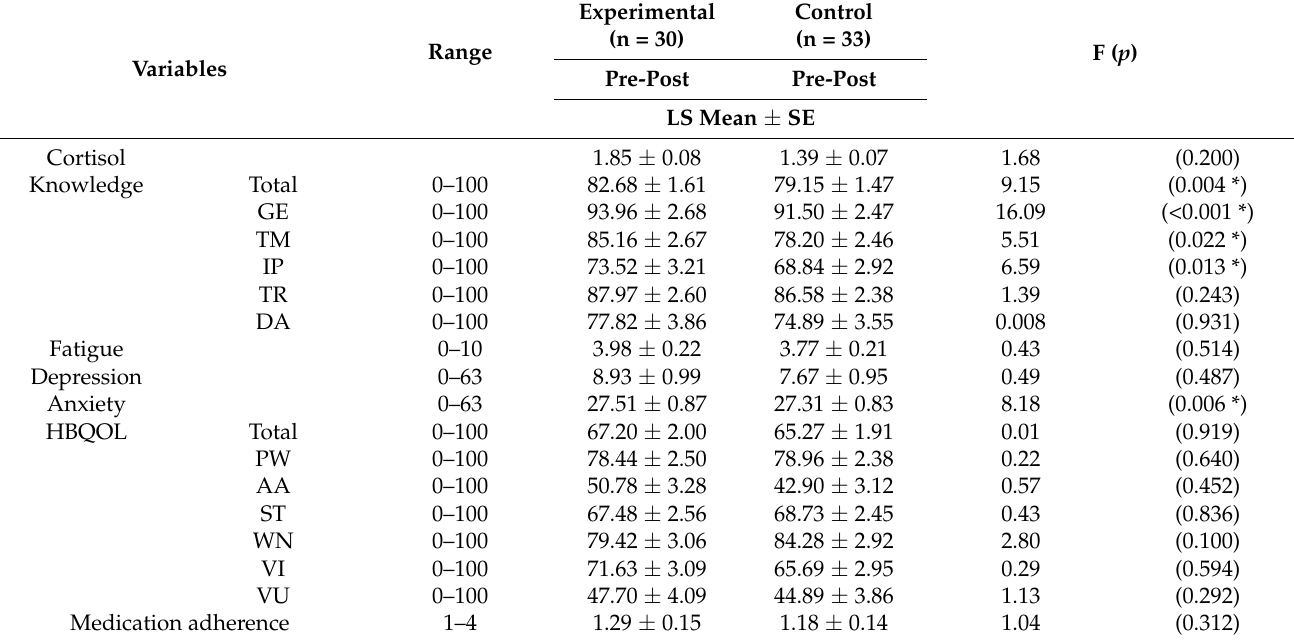
Table 3. Mean differences in outcomes after a 12-week pilot test of a smart app intervention for HBV management. N =